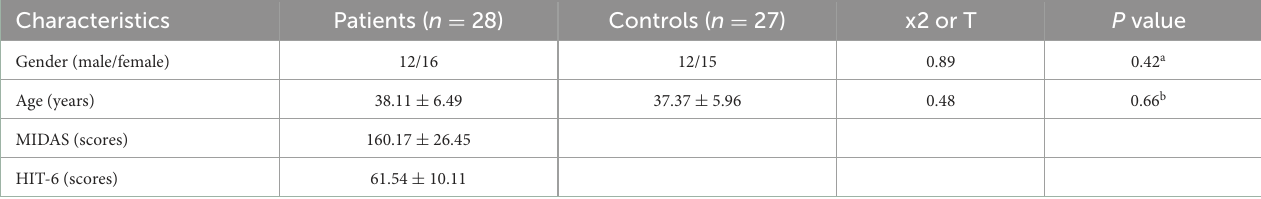
TABLE 1 Demographic characteristics of the study groups. Characteristics